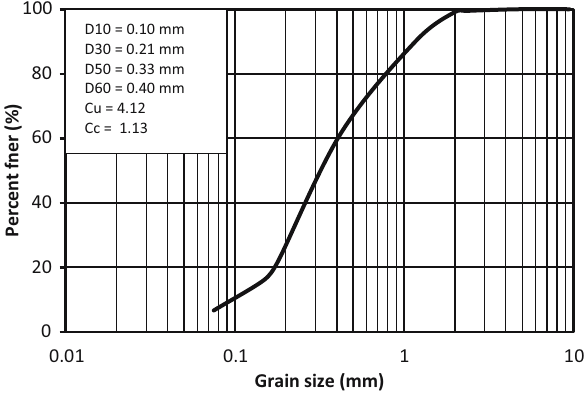
Figure 3: Grain size distribution of